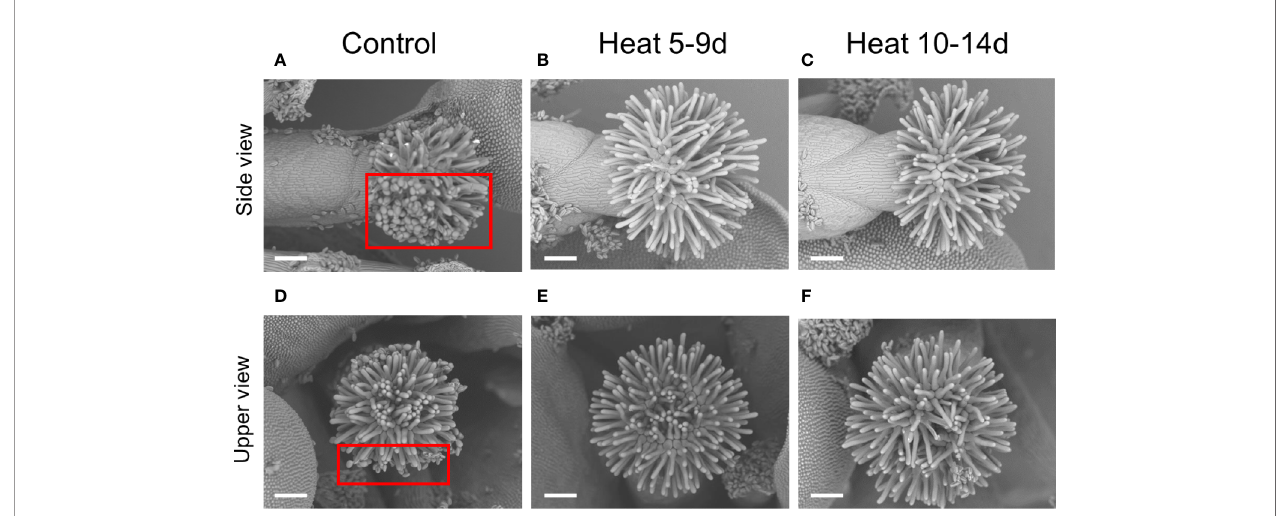
FIGURE 2 | Stigmas in fl owers of Arabidopsis plants (Colombia-0) photographed under a scanning electron microscope. (A – C) Side view of stigmas grown under control conditions (A) or subjected to heat stress (B, C) . (D – F) Top view of stigmas grown under control conditions or subjected to heat stress. Squares in (A, D) indicate the area of pollen attachment on stigma. Bars indicate 100 m m.